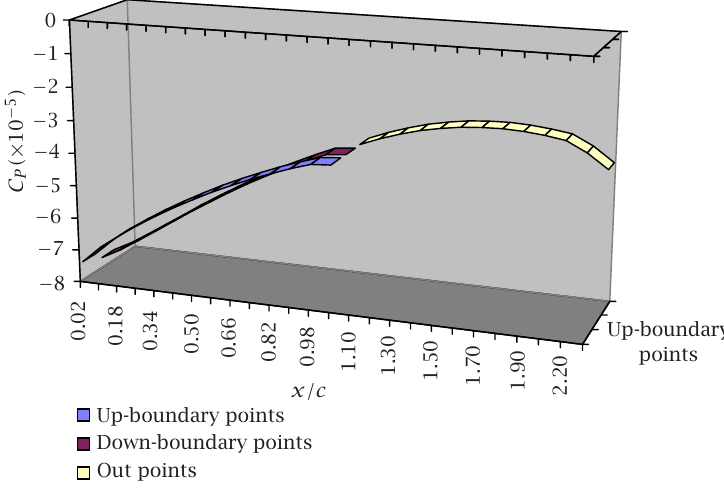
Figure 6.8 . Pressure distribution (3D form) around the aircraft of Figure 5.1, for linear vortex distribution and speed